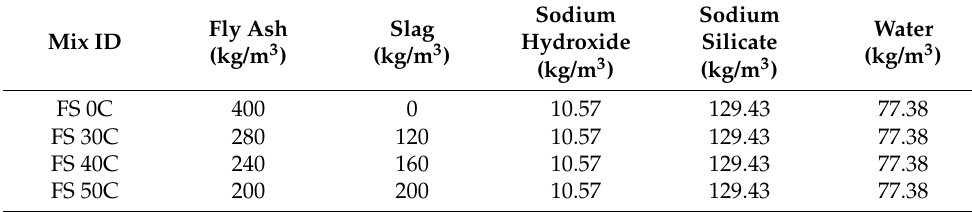
Table 3. Mix proportions of AAC